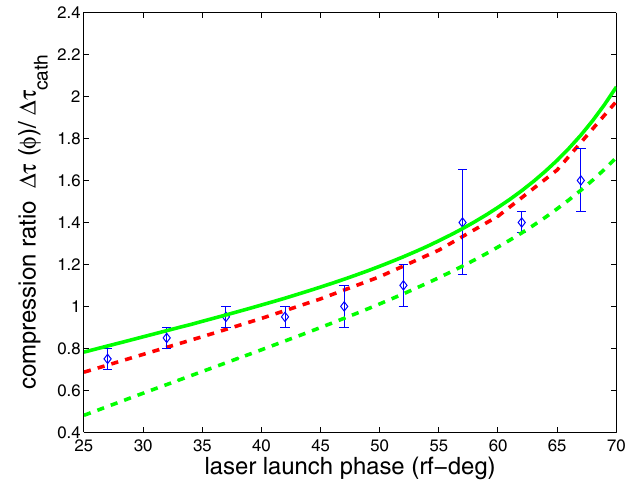
FIG. 4. (Color) Compression factor in the rf-gun cavity for various operating phases. Diamonds are experimental measure- ments, dashed red, solid green, and dashed green lines corre- spond, respectively, to numerical simulations with ASTRA , numerical integration of the equation of motion using the field ^ E obtained from SUPERFISH , and numerical integration assum- z (cid:2) cos (cid:7) kz (cid:8) (following Ref. [16]). ing ^ E z